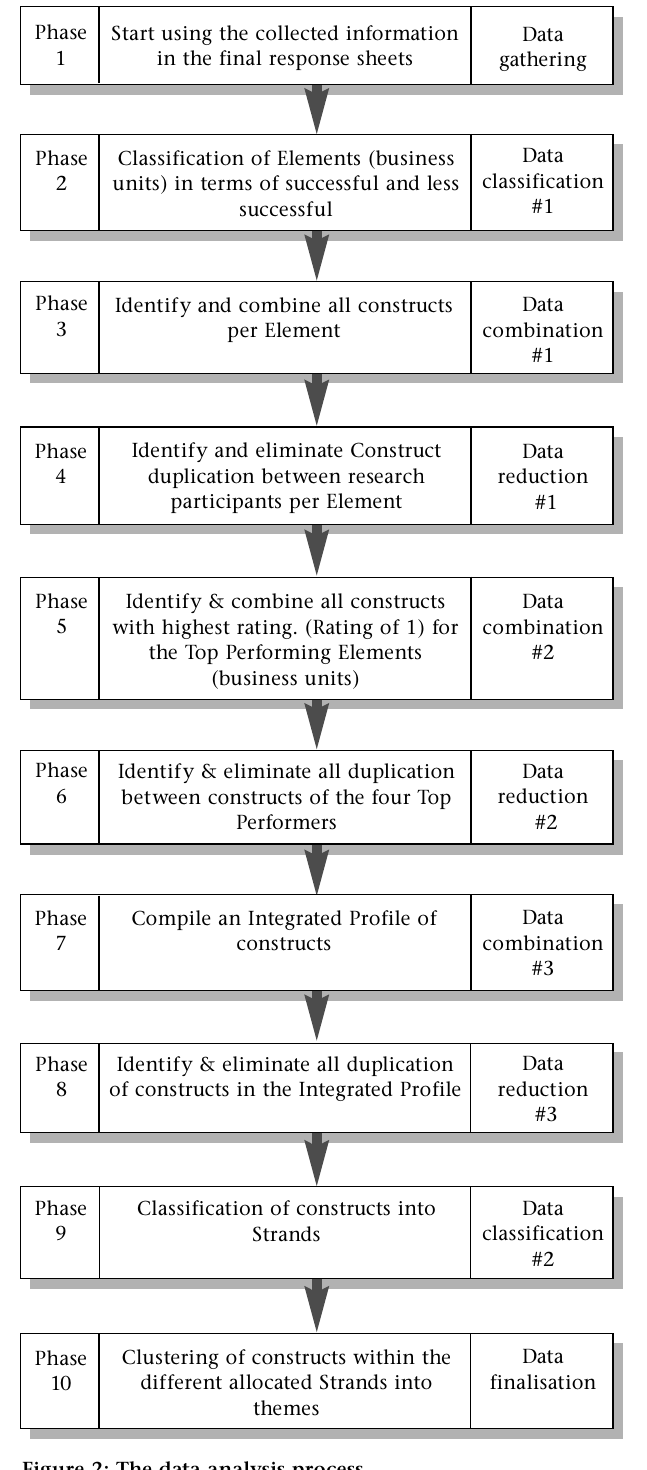
Figure 2: The data analysis